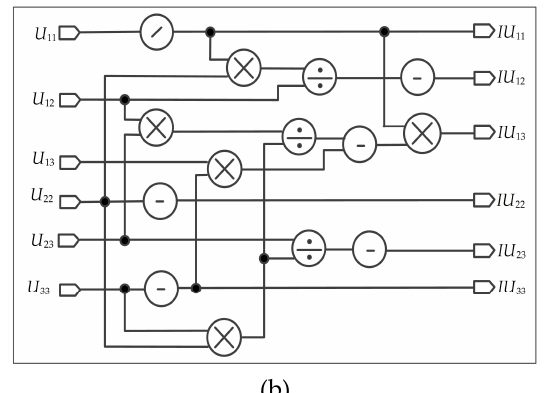
solving ( L 11 ) − 1 . ( b ) The architecture for solving ( U 11 ) − 1